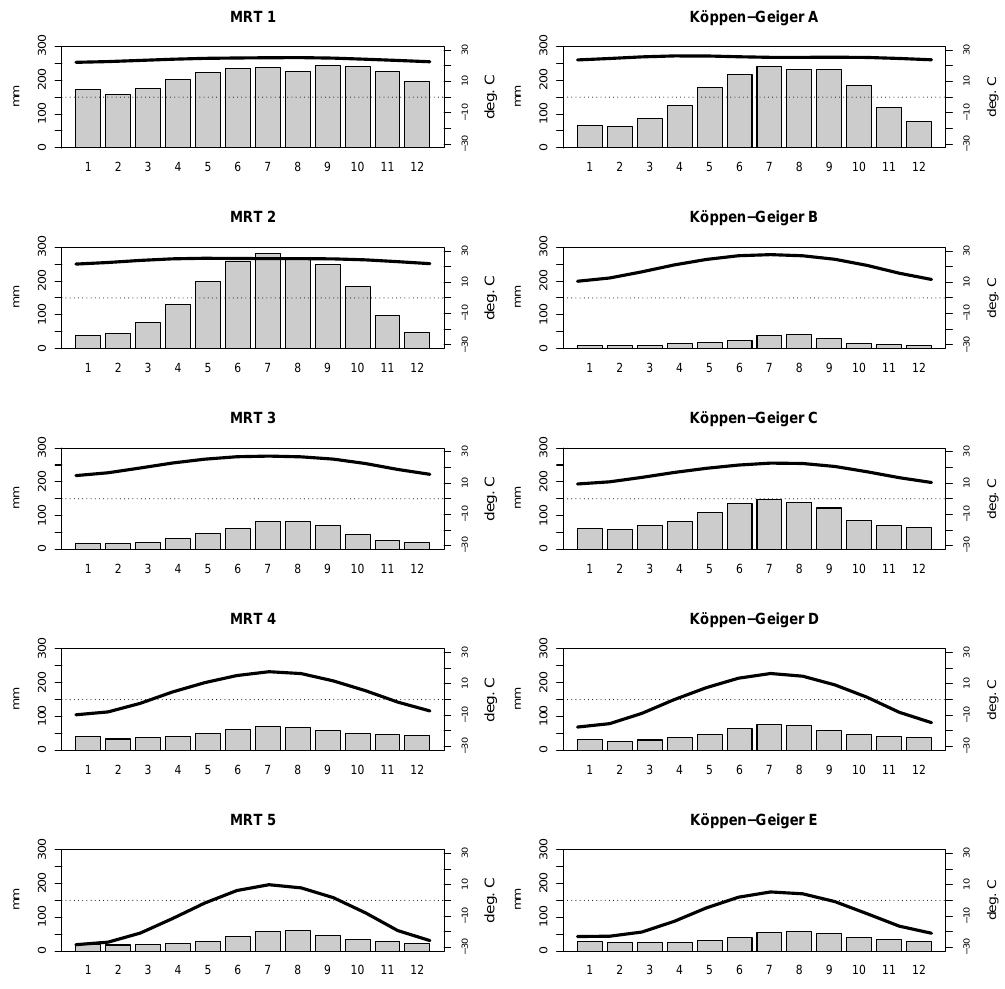
Fig. 6. Mean monthly temperatures (black line) and precipitation amounts (gray bars) for the K¨oppen-Geiger climate classification (right column) and MRT climate classification (left column) at the 5 class